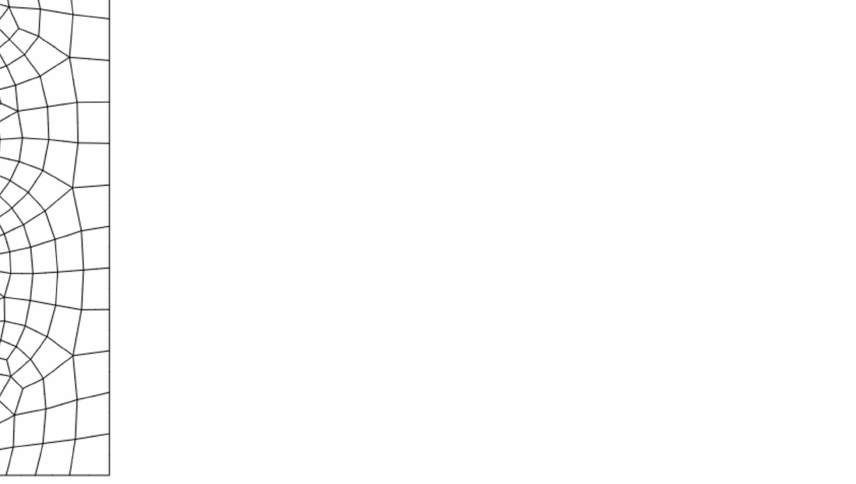
Figure 1. FE simulation